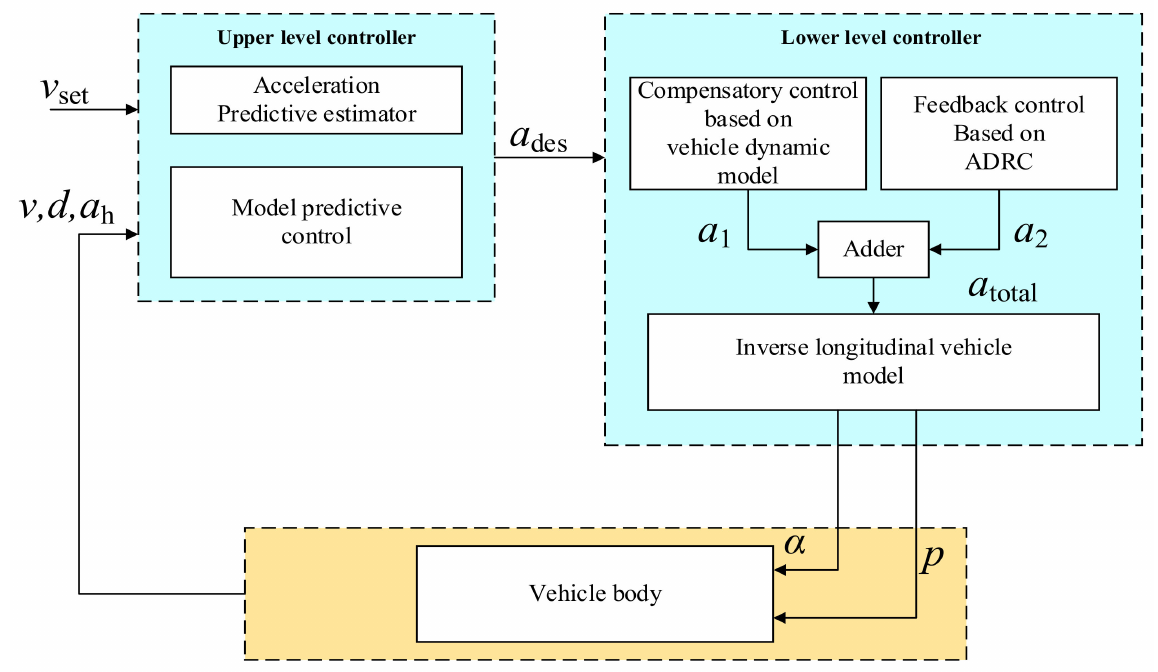
Figure 1. Schematic representation of the ACC